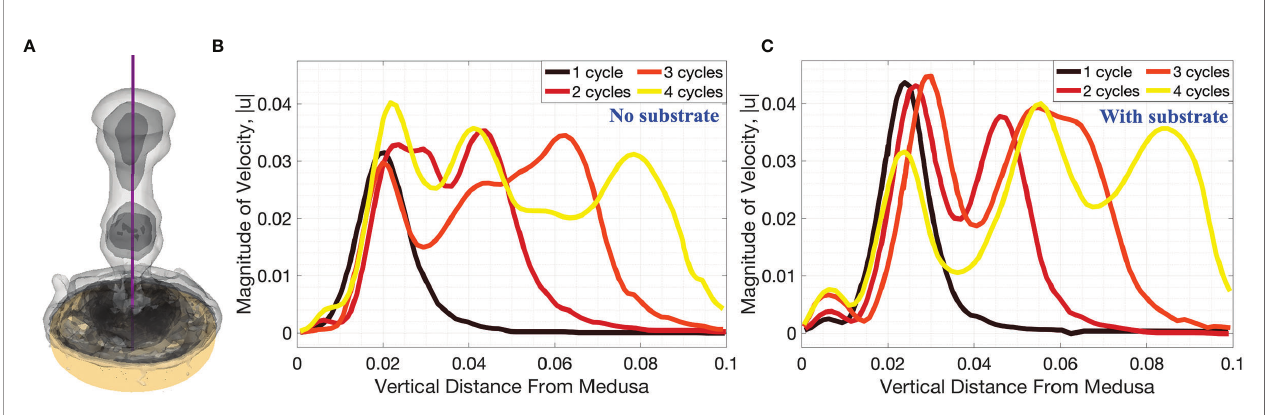
FIGURE 12 | 3D velocity magnitude (in units of m s -1 ) along the vertical centerline through the middle of the numerical bell, as depicted in (A) , for cases when (B) no substrate is present and (C) the bell is resting against the substrate. Data is provided at the end of the fi rst four pulsation cycles. Vertical distance is in units